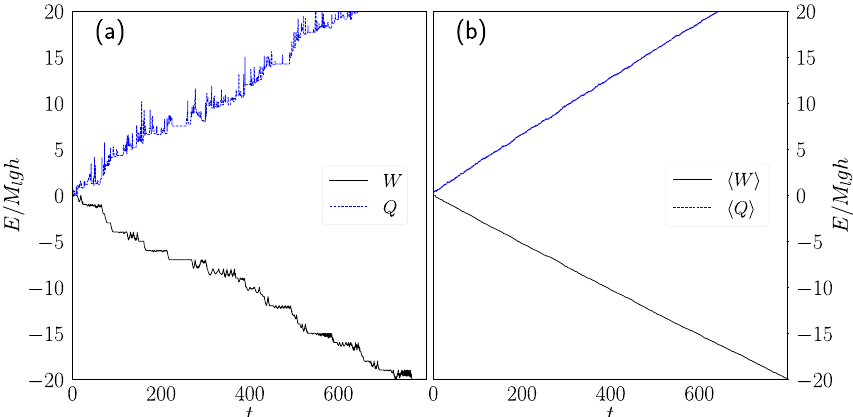
Figure 3. Work and heat vs. time. Work done to lift the load mass ( W ) and heat exchanged between the particle and the thermal walls ( Q ) during a simulation of the engine where p = 0.2 and M l = 1.0 . ( a ) Single simulation. ( b ) Ensemble average.